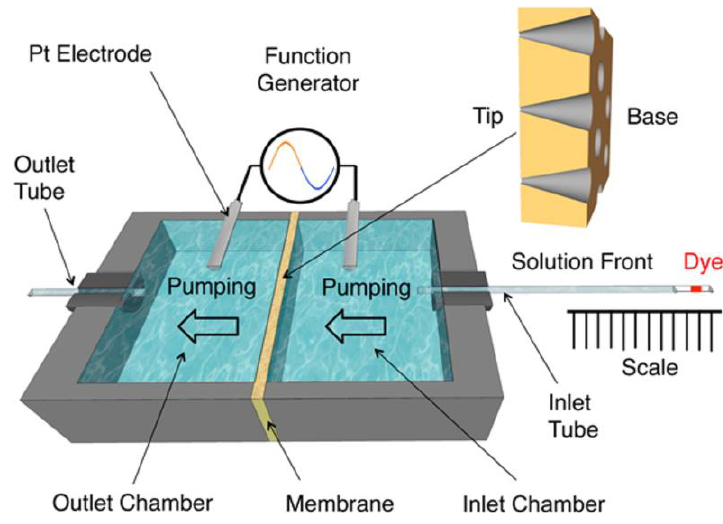
Figure 7. Schematic illustration of the AC electroosmotic flow (EOF) pump cell. A dye plug in the inlet tube was used to determine the EOF velocity. A net flow from base-to-tip was observed. Reprinted with permission from [11]. Copyright 2016, American Chemical Society.